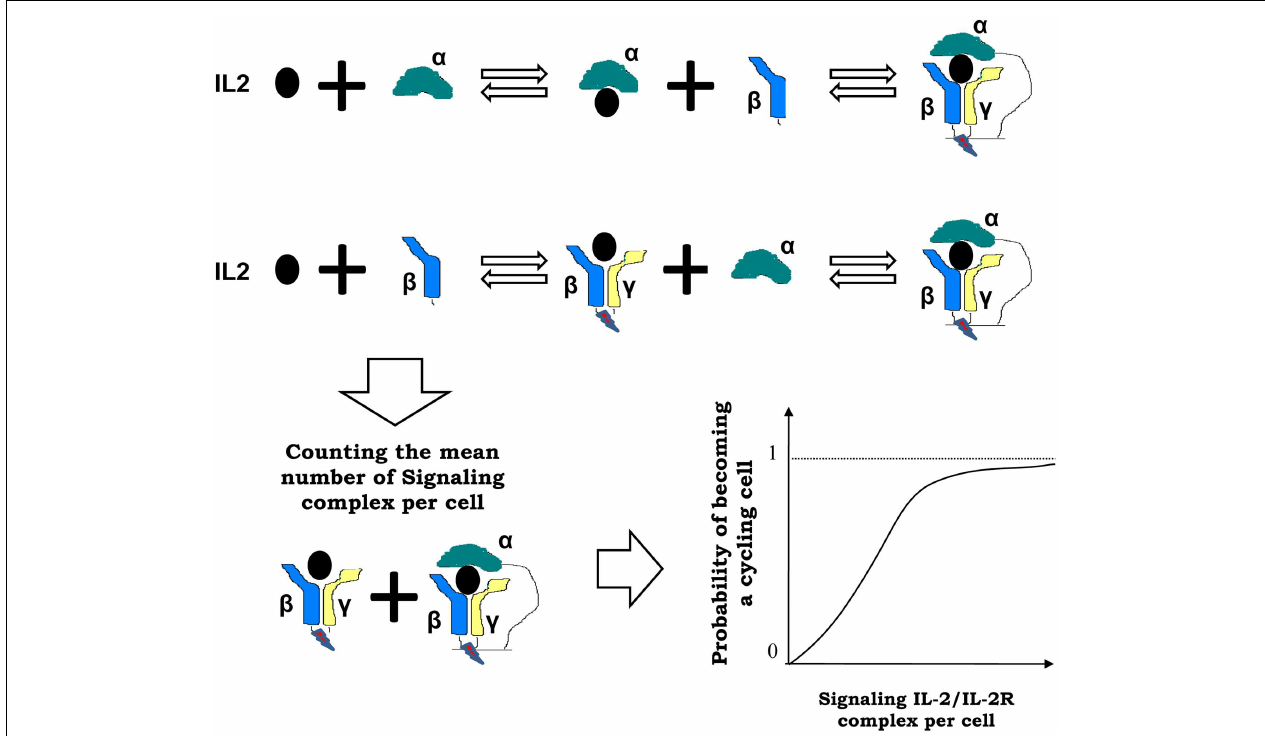
and intermediate affinity beta-gamma receptor. In the model, the mean number of such signaling IL2-IL2R complexes per activatedT cell are counted, and the probability of becoming a cycling cell is computed with a sigmoid function of the mean number of bound cytokines signaling receptors per cell (as shown at the right side of the